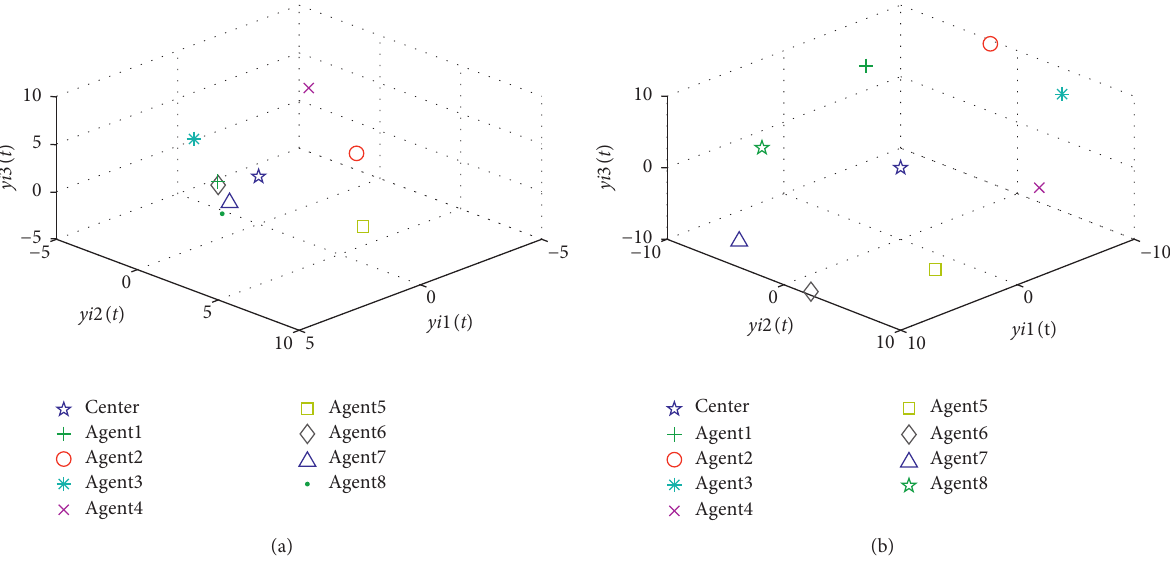
Figure 3: Output snapshots of eight agents with the robust controller. (a) t � 0 s. (b) t � 10 s.